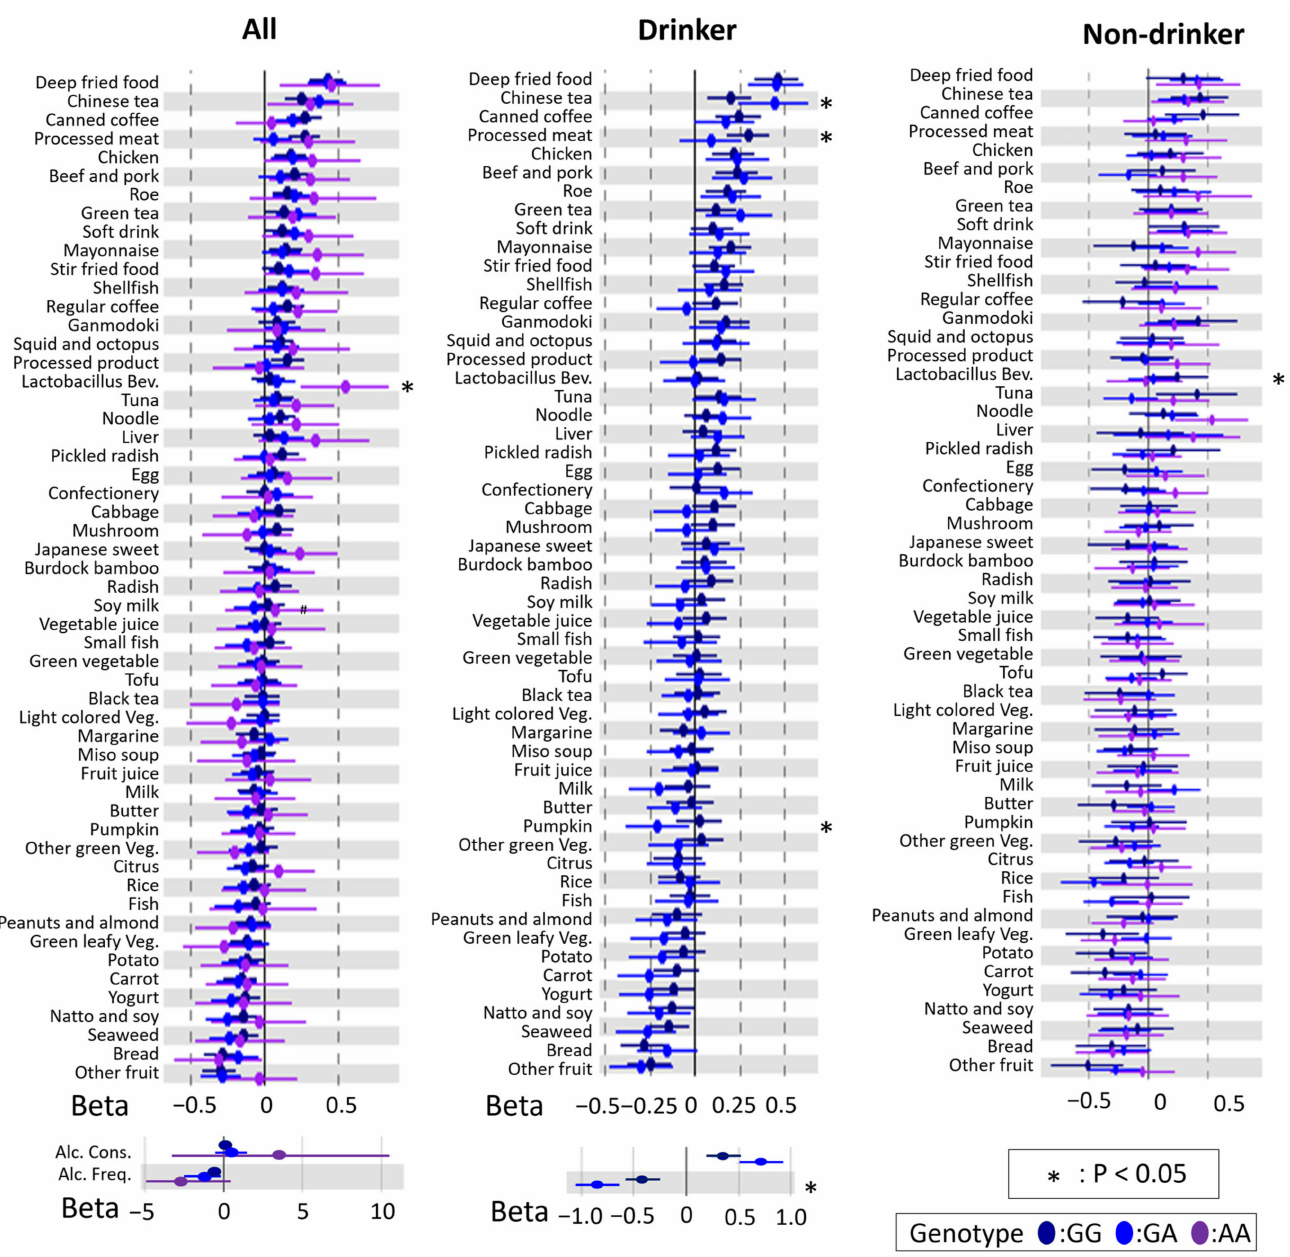
Figure 2. Forest plot showing association between dietary behaviors (DBs) and BMI modified by rs671 genotype in males. The X -axis and Y -axis show the standardized beta coefficient ± standard deviation and each DB, respectively. Dark blue, blue, and purple spots indicate the results for GG, GA, and AA types of rs671 genotypes, respectively. Alc. Cons, alcohol consumption; Alc. Freq., alcohol frequency; Lactobacillus Bev., Lactobacillus beverage; Green Veg, green vegetable; Green leafy Veg., green leafy vegetable; Green-yellow Veg, green-yellow vegetable; Light-colored Veg., light-colored vegetable. Asterisks indicate statistical significance for heterogeneity (*, p <